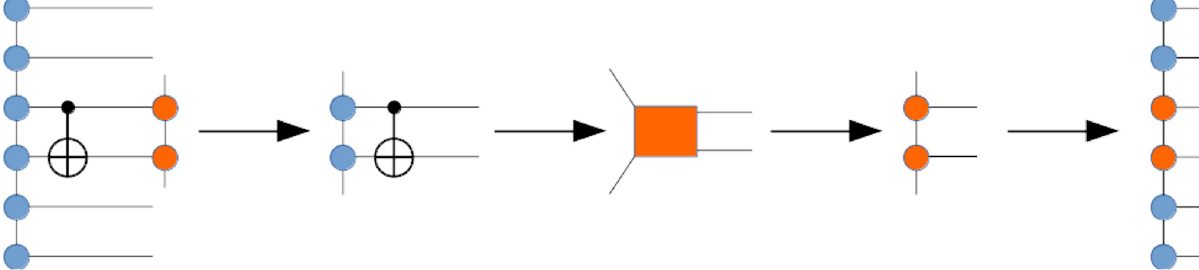
Fig 5. Graphical illustration of an accelerated evaluation of the action of a two-body gate on a pair of adjacent qubits in the MPS representation. The SVD procedure decomposes the rank-4 tensor into a pair of contracted rank-3 tensors, thus immediately producing the updated MPS tensors.